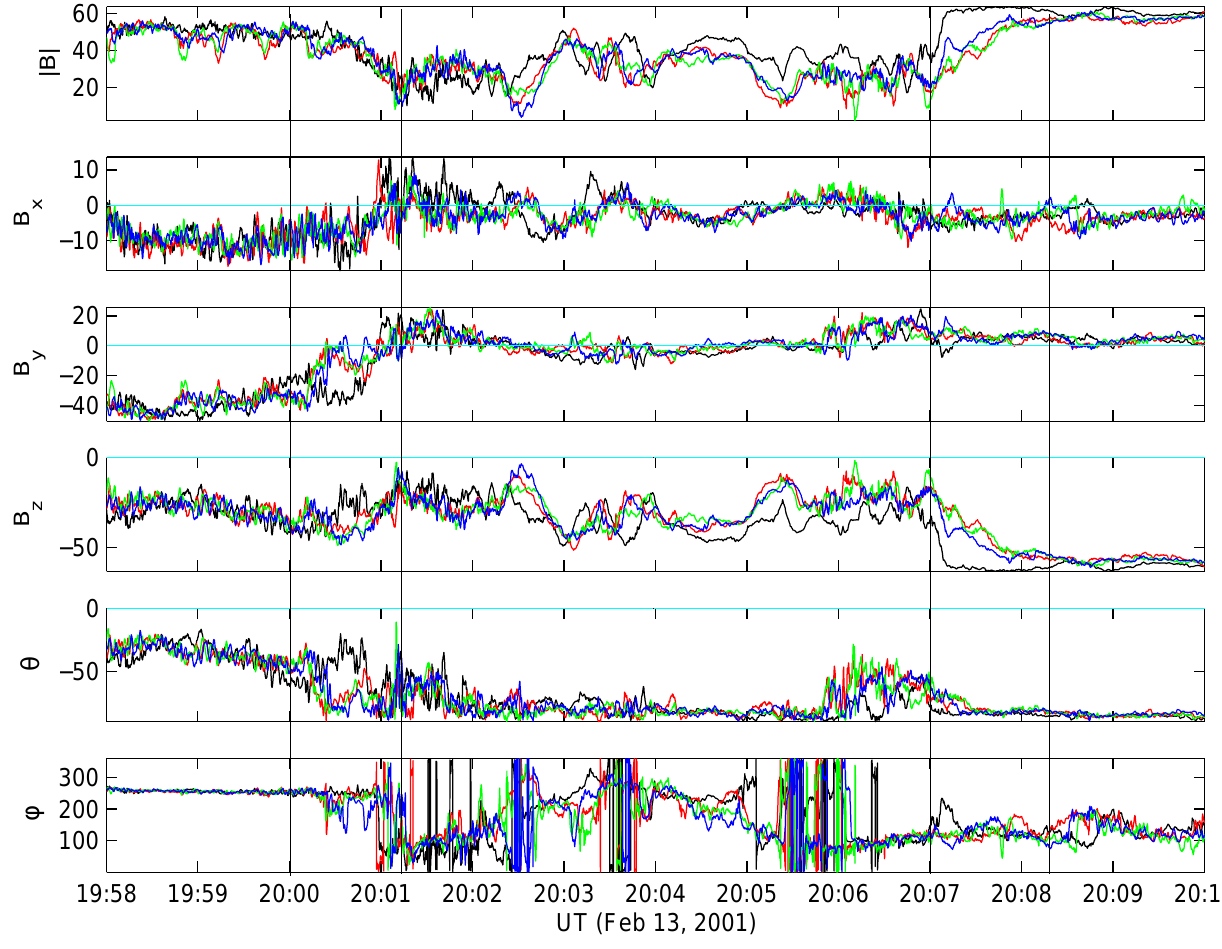
Fig. 6. The magnetic field with a resolution of 22.4 vectors per second from 19:58–20:10UT on 13 February 2001. The six panels show the magnetic field magnitude, components and orientations (expressed as the angles θ and φ) in GSE